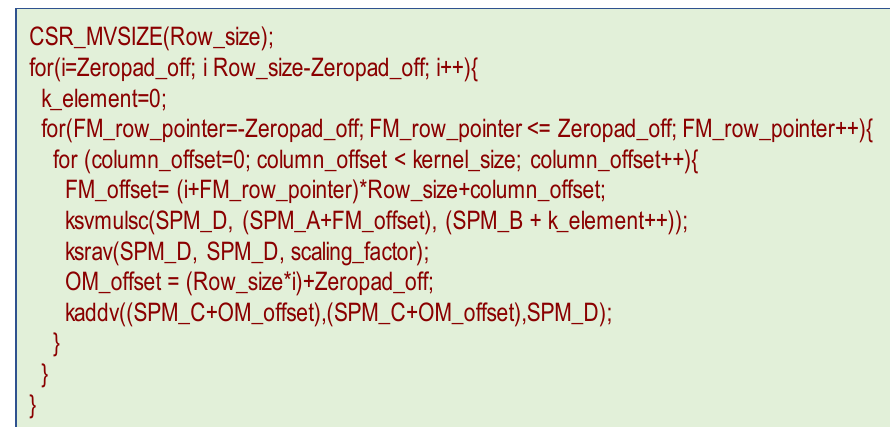
Figure 12. ( a ) Adding the bias to the Output Matrix; ( b ) Applying the ReLu function to the Output Matrix (Layers: 1, 2, 4, 5, 7, 8, 9, 11, 12, 13, 15, 16,